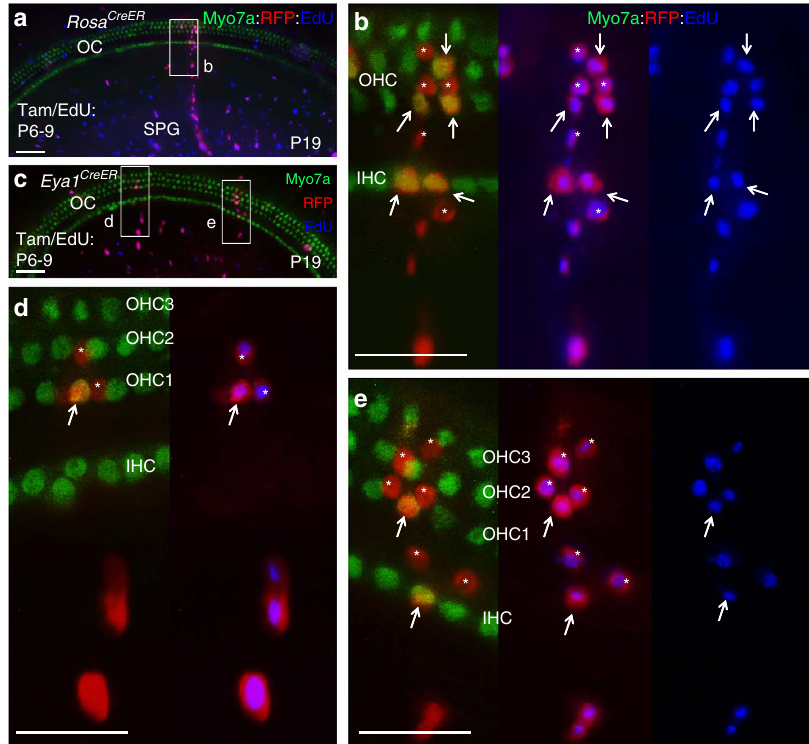
Figure 8 | Clonal and mitotic analysis in postnatal mouse cochlea. ( a ) Cochlea (middle turn) of P19 Rosa CreER ;Rainbow (given tamoxifen/EdU from P6 to P9) immunostained for Myo7a (green) and EdU (blue). ( b ) Higher magnification of boxed area in a . Red clonal cluster consists of EdU-incorporated Myo7a þ IHCs and OHCs (arrows) and Myo7a (cid:2) SCs surrounding the HCs (asterisks) within the OC and cells in their associated SPG. ( c ) Cochlea (middle turn) of P19 Eya1 CreERT2 ;Rainbow cochlea (given tamoxifen/EdU from P6 to P9) immunostained for Myo7a (green) and EdU (blue). ( d , e ) Higher magnification of boxed regions in b . All marked individual cells in each clonal cluster were EdU labelled. Arrows point to EdU þ Eya1 -lineage traced Myo7a þ IHC and OHCs and asterisks point to EdU þ Eya1 -lineage traced Myo7a (cid:2) SCs. Scale bars: 50 m m ( a , c ); 30 m m ( b , d , e